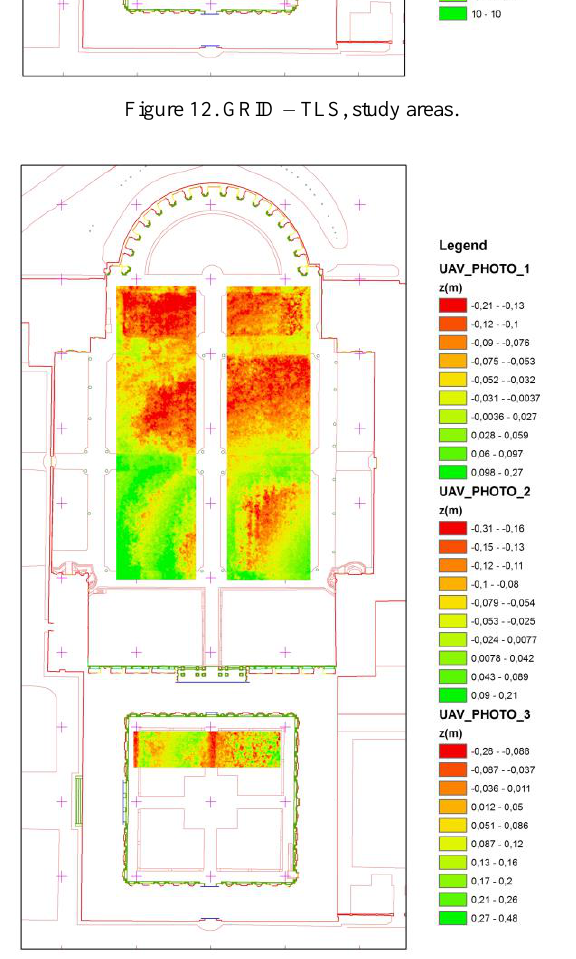
Figure 13. Delta UAV-Aerial Photogrammetry, study